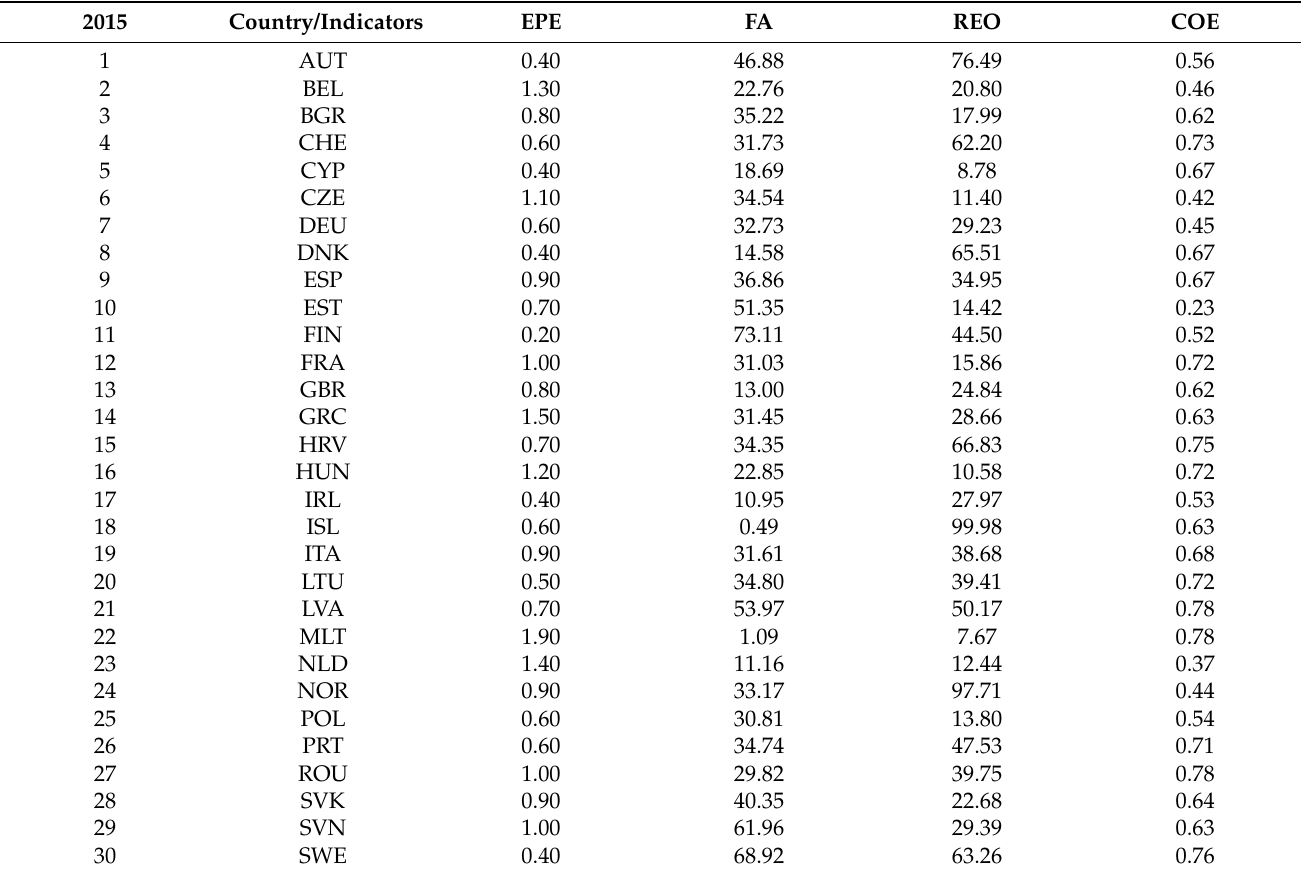
Table 2. Diagnostic set of input and output data—European countries in 2015. Source: World Bank [127], Eurostat [126].